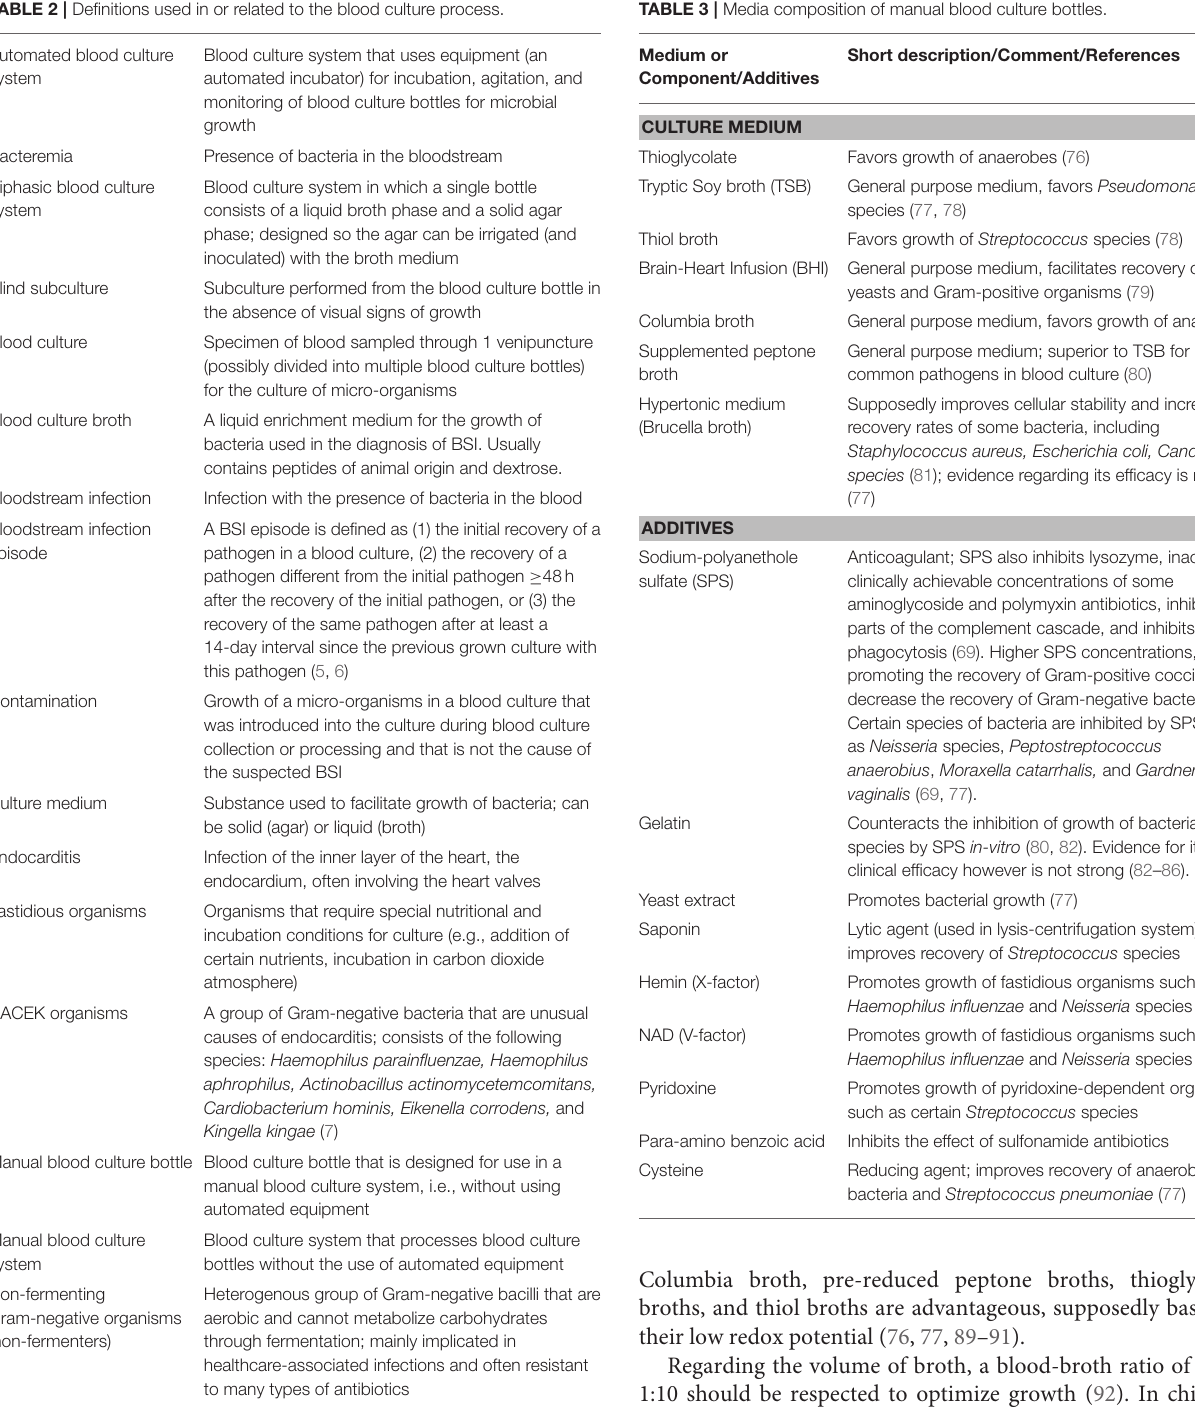
TABLE 3 | Media composition of manual blood culture